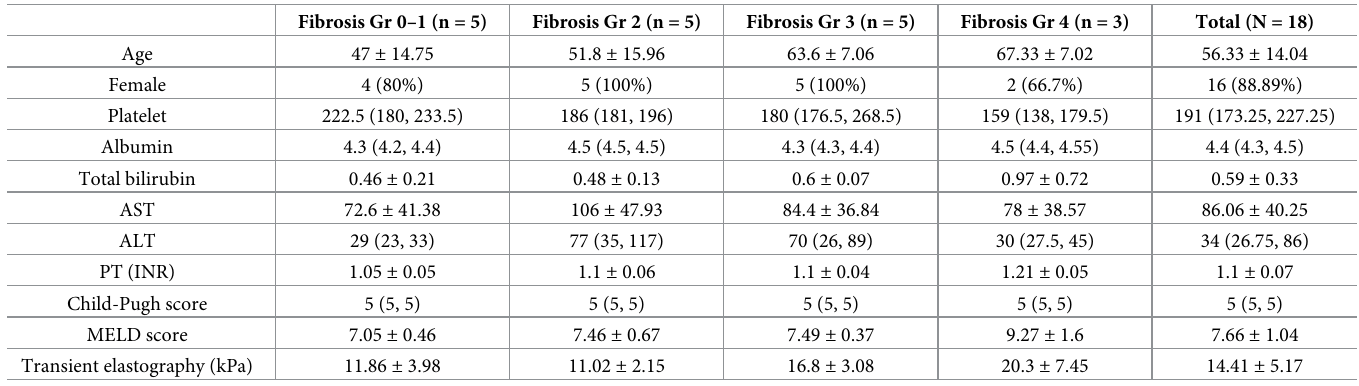
Table 2. The baseline characteristics of the selected patients for next-generation sequencing of exosomal microRNAs.